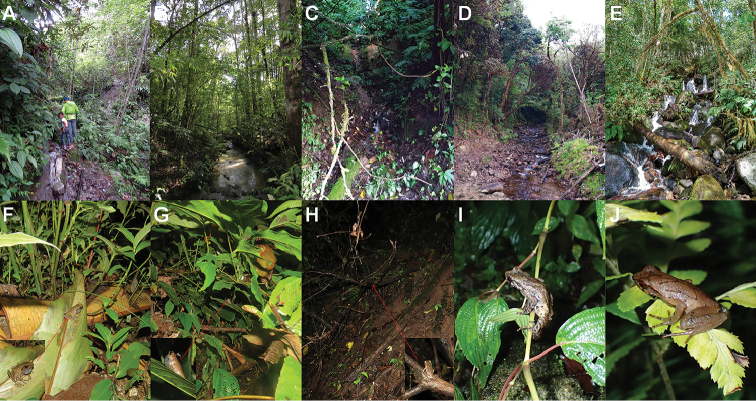
Microhabitats of Megophrys toads in the field in Medog. A stream at elevation 850 m in Didong village, harboring the low-middle-elevation M.
medogensis and Megophrys
yeae sp. nov. B a stream at 1530 m in Gelin village, hosting the low-middle-elevation M.
medogensis and M.
pachyproctusC a stream at 1780 m in Bari village, harboring low-middle-elevation M.
medogensis, M.
cf.
pachyproctus and Megophrys
yeae sp. nov. D a stream at 2003 m in the vicinity of Renqingbeng Temple, hosting M.
cf.
pachyproctus and Megophrys
zhoui sp. nov. E a stream at 2142 m in Gedang village, hosting M.
medogensisF one adult male of low-middle-elevation M.
medogensis calling on a dead leaf on the tropical forest ground nearby a stream in Didong village G the adult male paratype CIB022017061102 of Megophrys
yeae sp. nov. calling on a leaf of dense bushes under tropical forest, ca. 0.5 m above a stream in Didong village H the adult male CIB022017061806 of M.
cf.
pachyproctus calling on a branch of dead bush, ca. 0.5 m above ground under subtropical forest in Bari village I the gravid female CIBMT171054 of M.
cf.
pachyproctus precariously climbing up onto a stem of herb, ca. 0.3 m above a tiny stream under subtropical forest in Renqingbeng J the adult male holotype CIBMT171053 of Megophrys
zhoui sp. nov. sitting on a split of a fern leaf in a small stream under subtropical forest in the vicinity of Renqingbeng Temple.